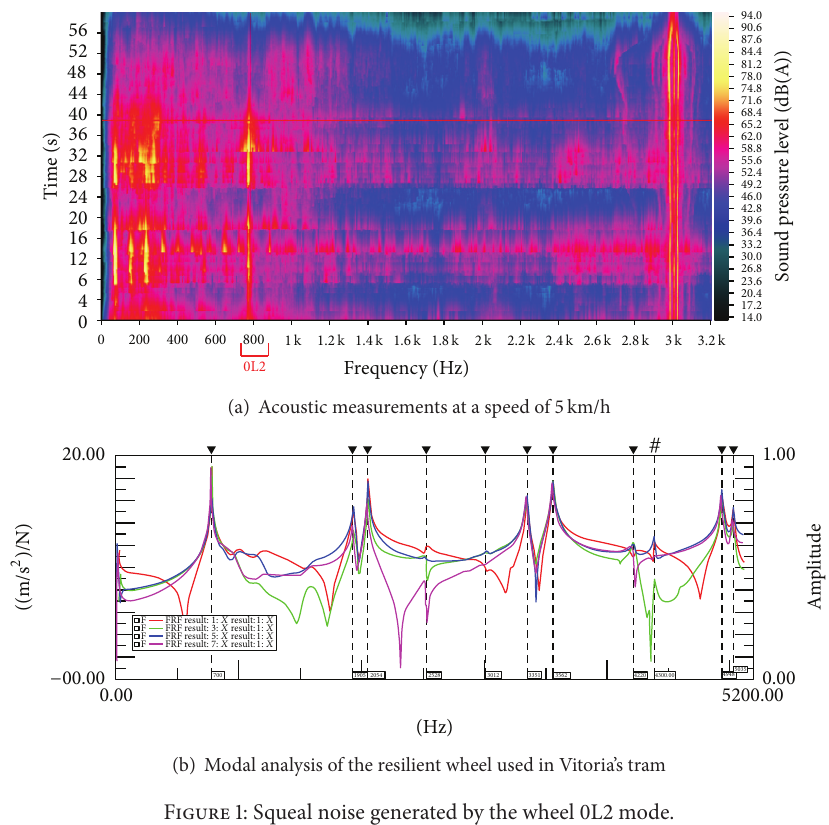
Figure 1: Squeal noise generated by the wheel 0L2 mode.